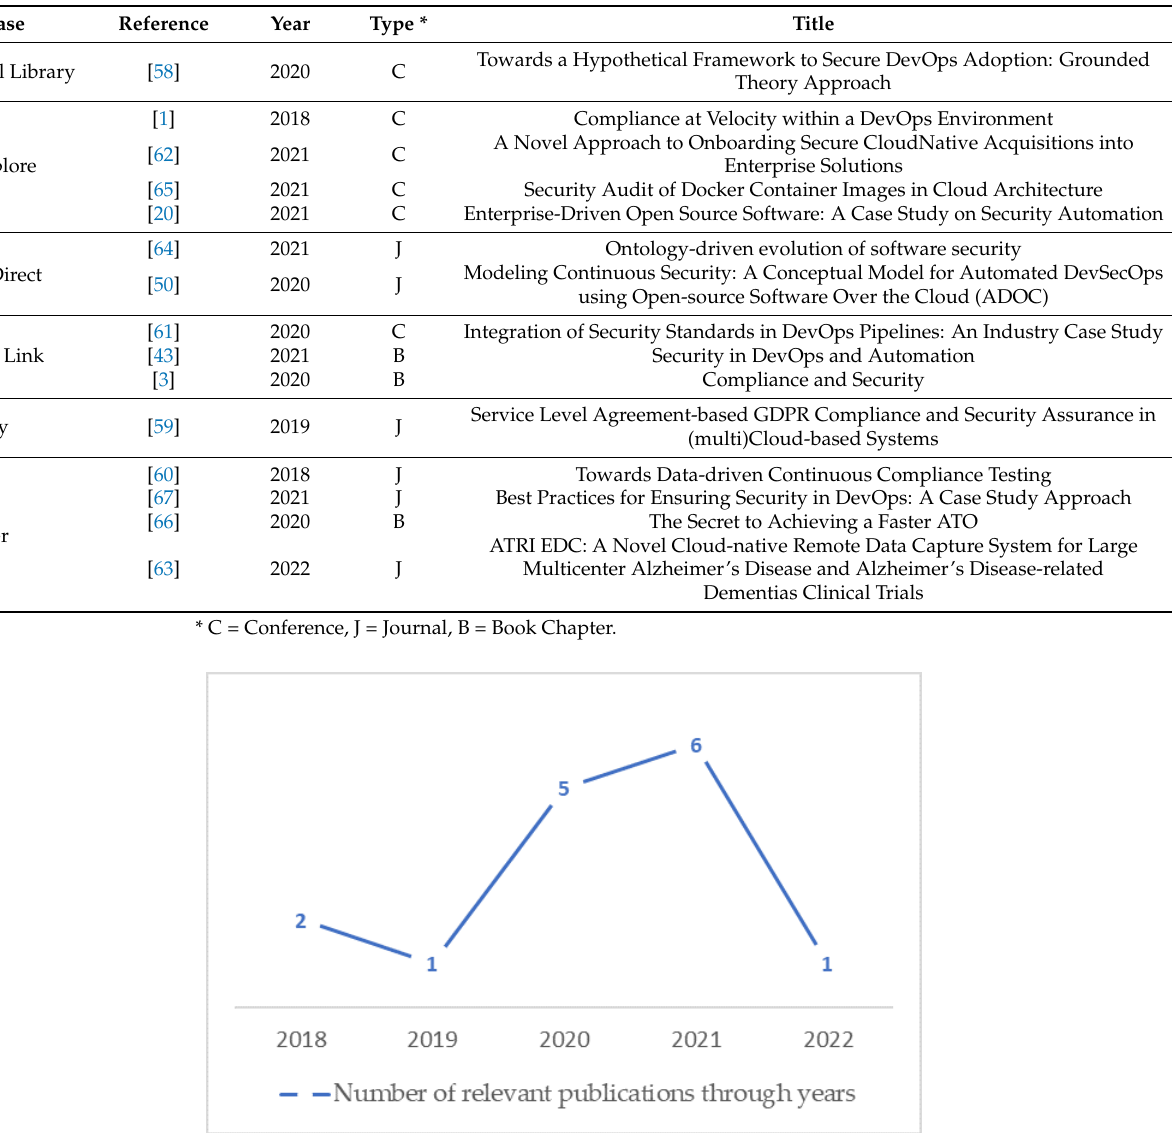
Table 3. Overview of Primary Studies.